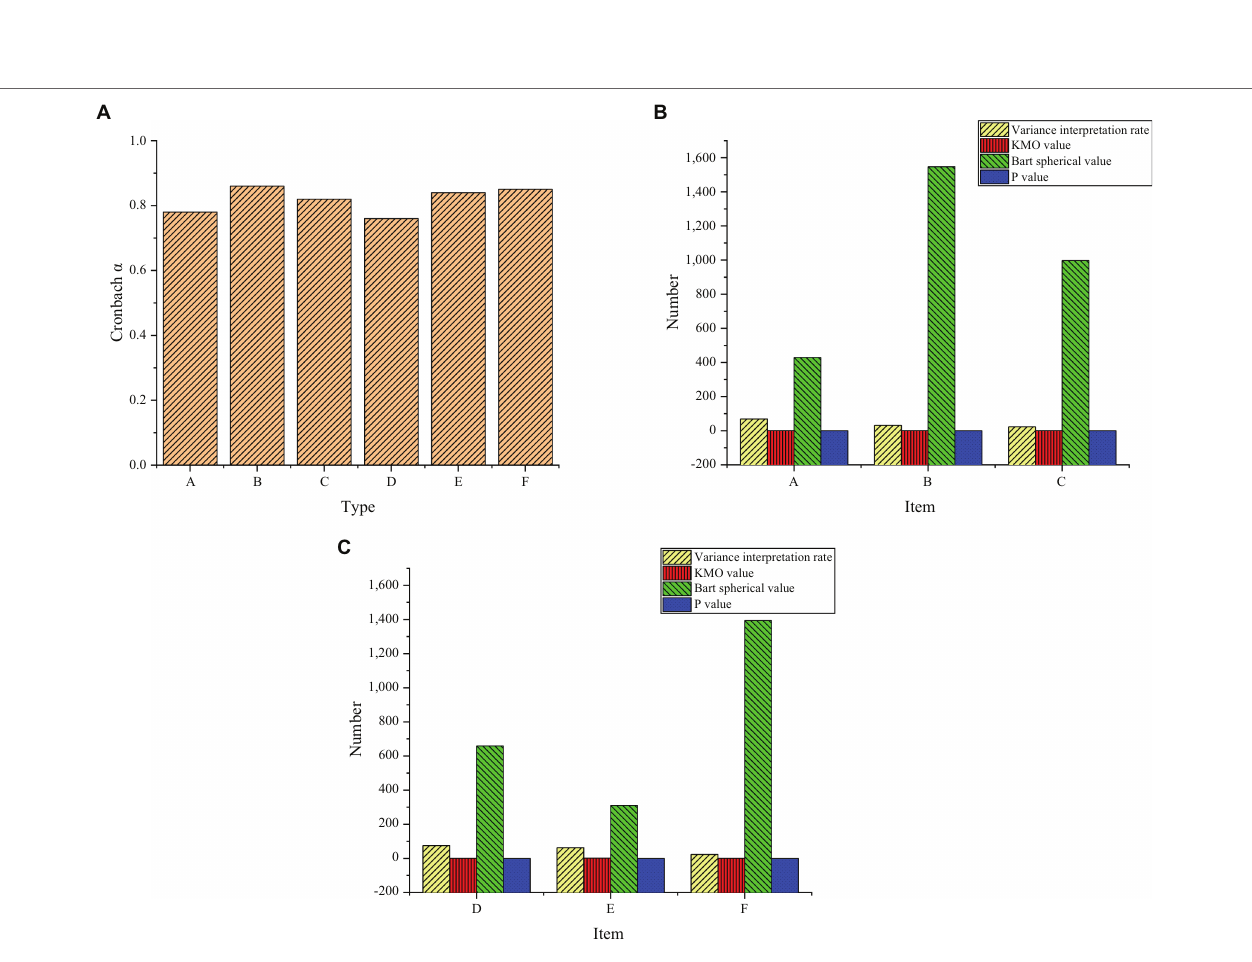
FIGURE 7 | Reliability and validity analysis of questionnaire content— (A) reliability analysis results of the questionnaire; (B) : validity analysis of content variables in the questionnaire; (C) : validity analysis of teacher content variables in the questionnaire; A: Interest; B: Exploratory; C: Learning mastery; D: Students’ interest in learning; E: Key content explanation; F: Student participation.